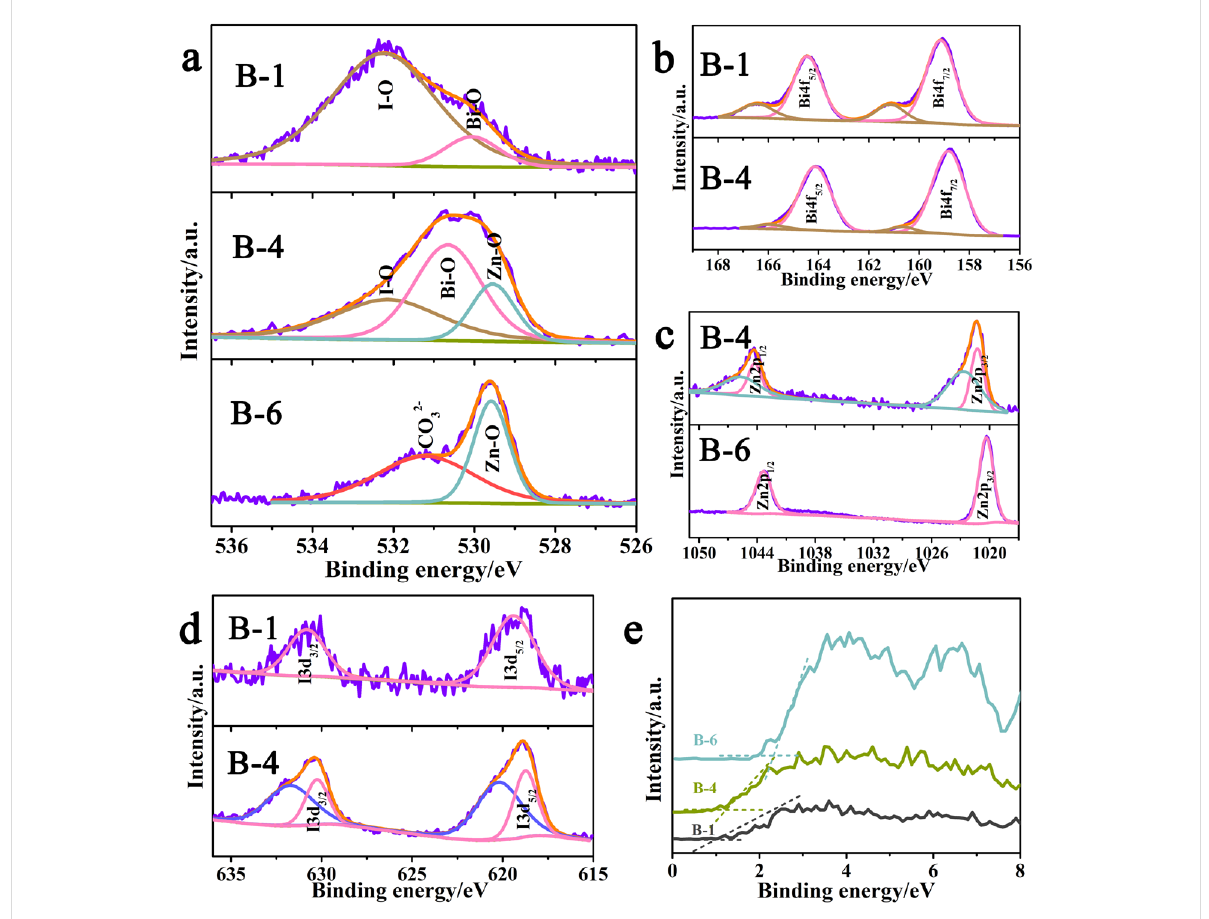
Figure 4: The high-resolution XPS spectrum for: (a) O 1s core energy of B-1, B-4 and B-6; (b) Bi 4f of B-1 and B-4 samples; (c) Zn 2p of B-4 and B-6 samples; (d) I 3d of B-1 and B-4 samples; and (e) XPS valence band spectrum of samples B-1, B-4 and B-6.